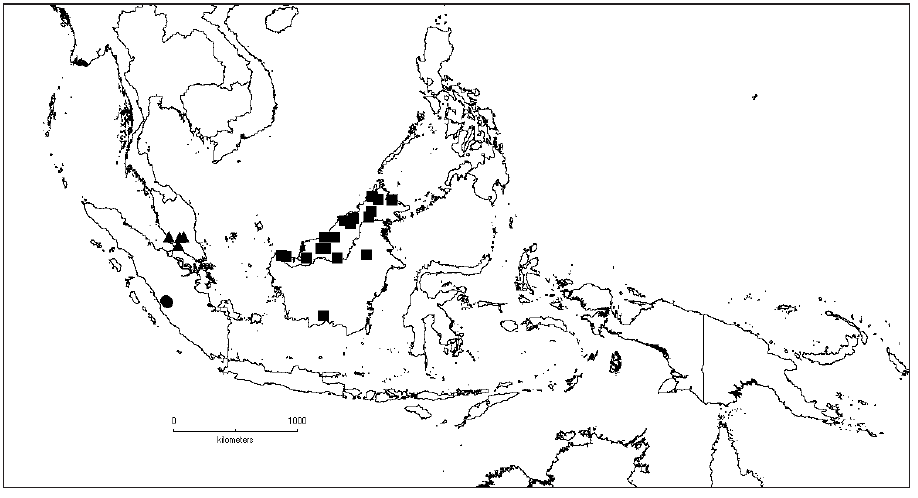
Map 15. Distribution of D. glandiformis ( ● ), D.glandulosa ( ■ ) and D. griffithii ( ▲